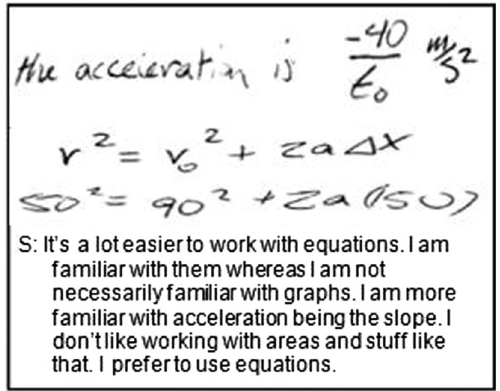
FIG. 11. Solvevaluefromgraphicalrepresentations(question5).